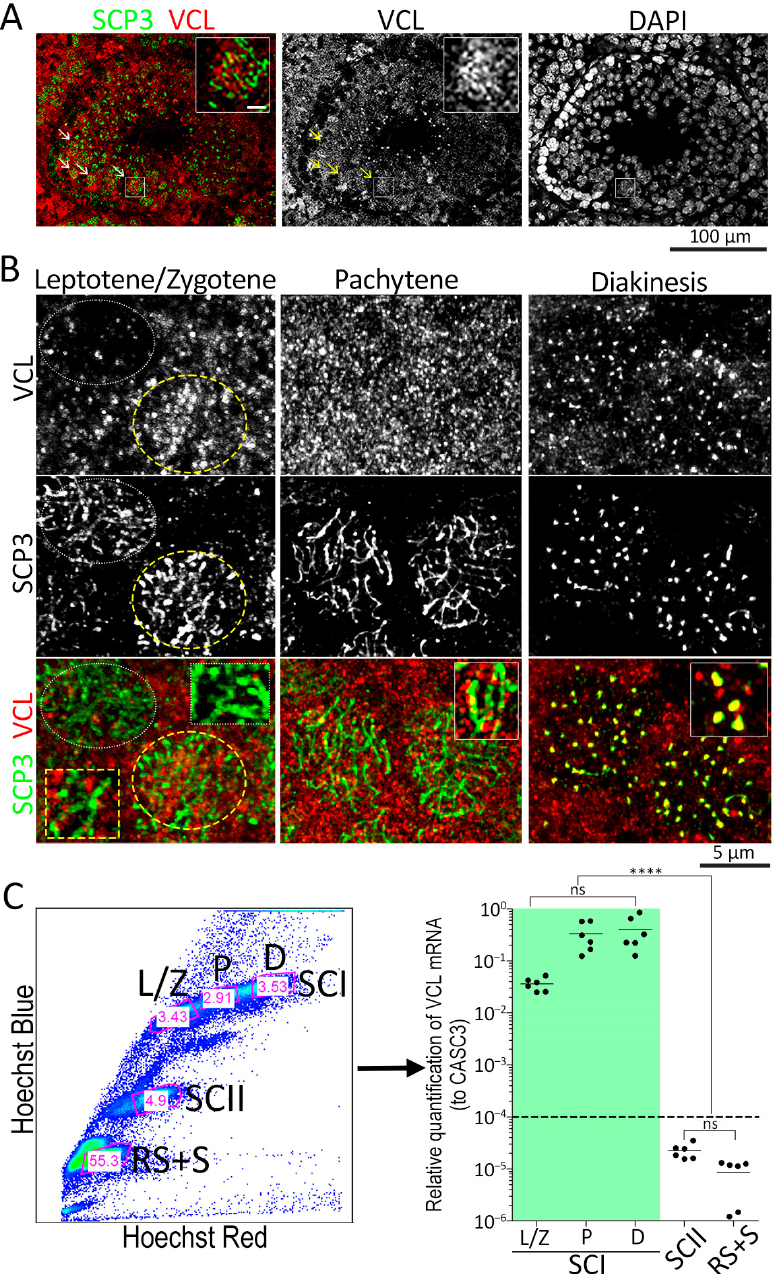
Figure 1. VCL in the nuclei of meiotic cells. ( A ) Immunofluorescence staining on 5 µ m-thick sections of testes sections revealed VCL localization not only in Sertoli cells (tubular signal) but also at the area of primary spermatocytes (arrows; figure inset, scale bar = 5 µ m); ( B ) detailed observations of VCL localization of testes sections, where leptotene SCs (dotted line) contain no VCL, which appears first in zygotene (yellow dashed line) remaining until diakinesis; ( C ) single-cell suspension indicated with Hoechst 33342 and measured emissions in red and blue light spectra, resulting in a typical scythe-like profile of spermatocyte populations. Sorting gates (pink) are depicted in the area of the sorted cells, with indicated perceptual proportion of cell content for all cells. Spermatogenic cells were FACS-sorted according to their ploidy and used for VCL mRNA relative quantification (comparing the expression level to house-keeping CASC3). VCL expression peaked in the pachytene and diplotene stages (green box). The level of VCL mRNA in other cells was below the limit of positivity (dashed line). Each value represents a biological replicate, i.e., one wild-type male mouse. For sta- tistical evaluation, an unpaired t-test was applied, where ns = 0.1744 and highly significant (****) p < 0.0001. Key to the figure: SCI = primary spermatocyte; L/Z = leptotene/zygotene; P = pachytene, D = diplotene; SCII = secondary spermatocyte; RS + S = round spermatids and sperm. To better visualize the VCL pattern in the primary spermatocytes of the testes sec- tions, VCL was localized on spermatocyte spread samples [63]. Prophase I staging was